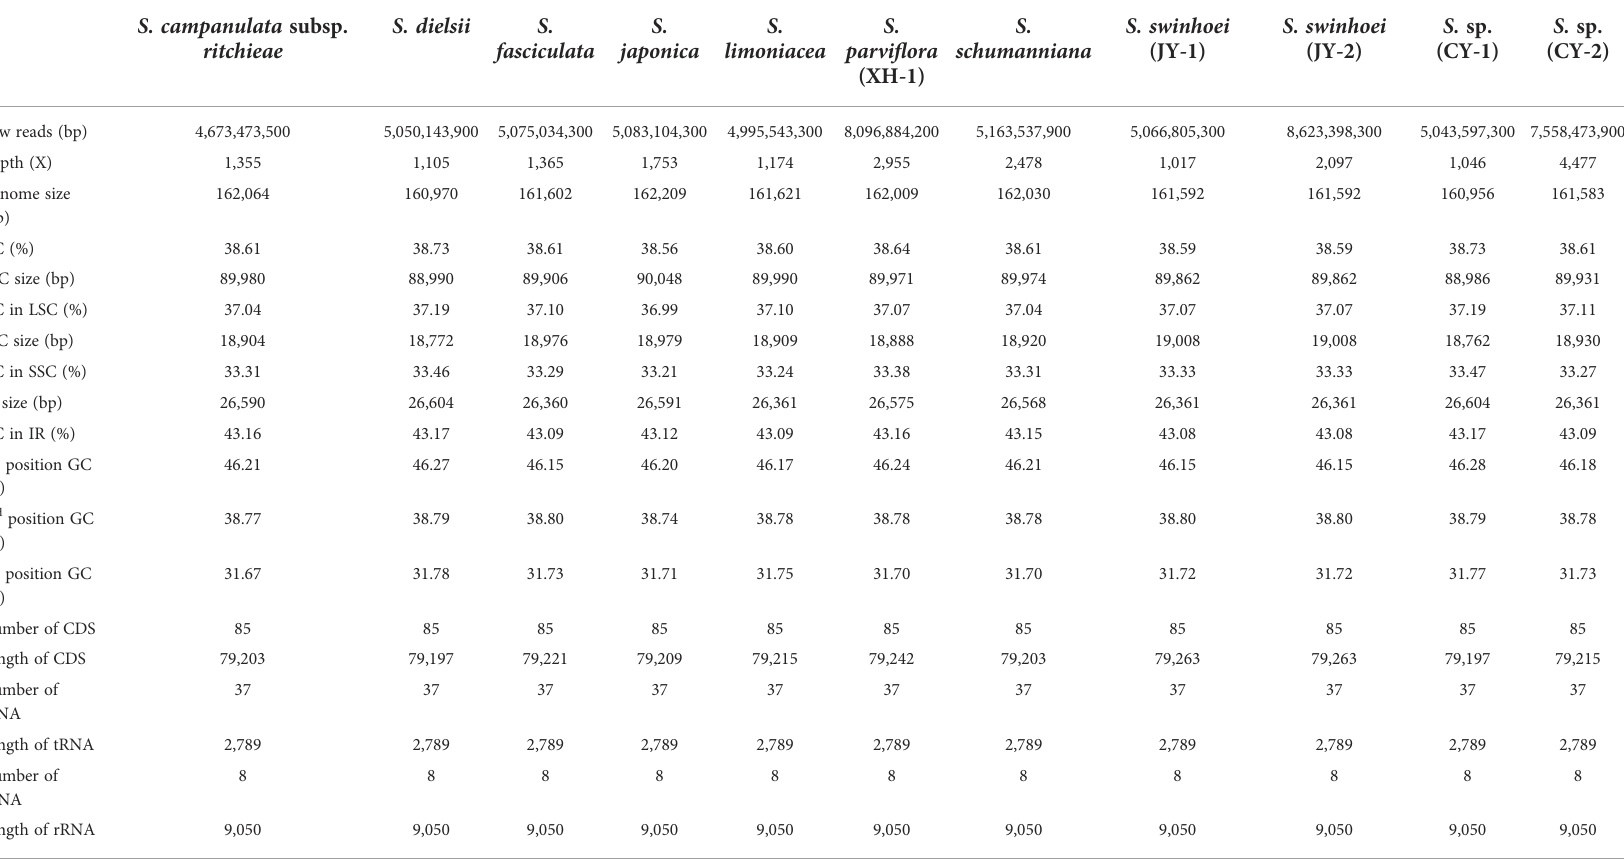
TABLE 2 Features of 11 Sabia chloroplast